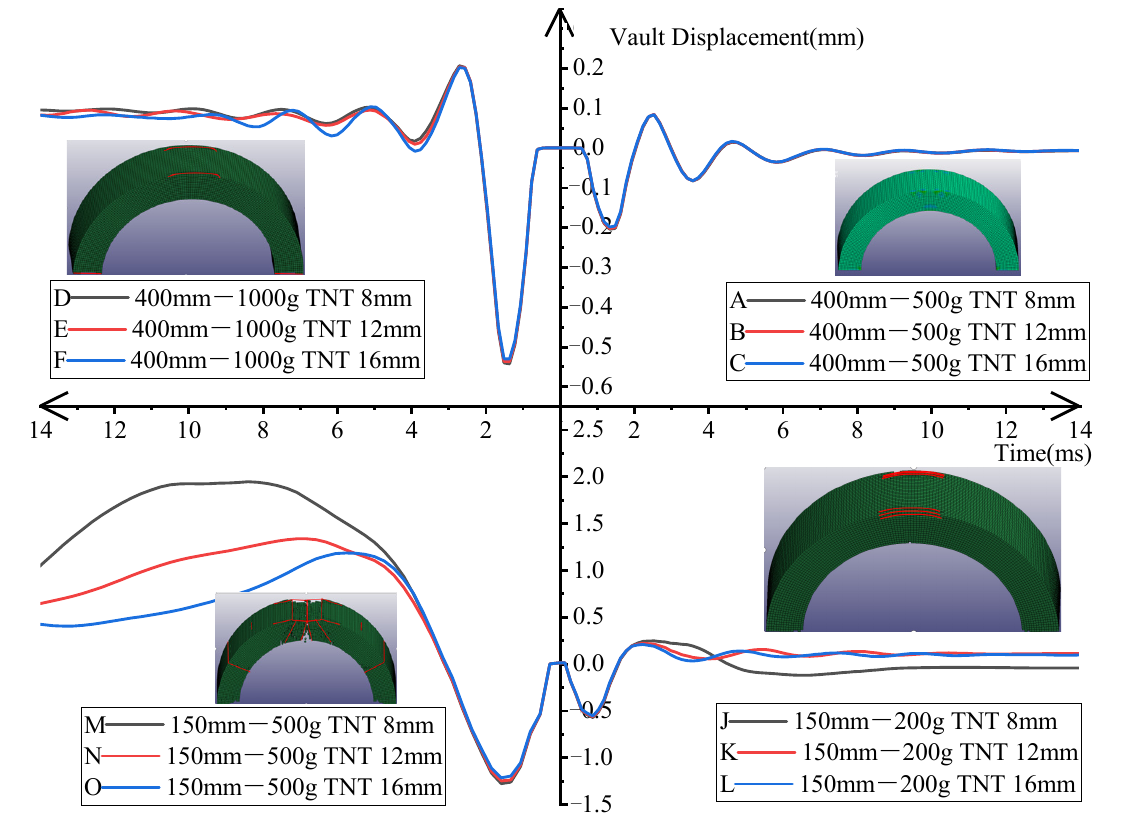
Figure 12. Time history curves of the dynamic displacement at the vault under various conditions. When the standoff distance was 0.4 m and the amount of TNT was 0.5 kg, the displacement curves of the three BBCAs were almost the same. The first displacement peak point appeared immediately after the explosion and then the second peak point appeared due to the rebound. However, the second peak value was less than the first peak value. After that, the displacement of the arch fluctuated sinusoidally until the displacement returned to zero, indicating that the arch structure was still in the elastic stage and could maintain its original shape. When the amount of TNT increased to 1 kg, the displacement peaks of the three BBCAs were still almost the same, but there were slight differences in the elastic recovery stage. At this time, the arch structures were only slightly damaged on both sides of the vault. When the standoff distance was 0.15 m and the amount of TNT was 0.2 kg, the BBCAs with three diameters showed different responses after the arch structure reached the peak displacement. The 8 mm diameter BBCA slowly descended after reaching the peak displacement and there was still residual displacement after the explosion. At this time, both sides of the vault were damaged. The 12 mm and 16mm diameter BBCAs descended rapidly after reaching the peak displacement and finally returned to zero. Thus, the arch structure still maintained elastic deformation. By increasing the amount of TNT to 0.5 kg, the arch was significantly damaged and a large area of the concrete was broken at the top of the vault and obvious cracks appeared at the hance. At this time, the three BBCAs showed different behaviors after reaching the peak displacement. The displacement of the 8mm BBCA continued to increase and reached the maximum of 1.92 mm and then dropped. The maximum displacement of the 12 mm BBCA reached 1.31 mm and then decreased. The maximum displacement of the 16 mm BBCA reached 1.29 mm and the residual displacement of the vault was less than those of the 8 mm and 12 mm BBCAs. From the above analysis, the contribution of the BFRP bars was not significant when the arch was in the elastic deformation. While the arch structure was severely damaged, the BFRP bars could make a significant contribution to the blast resistance of the